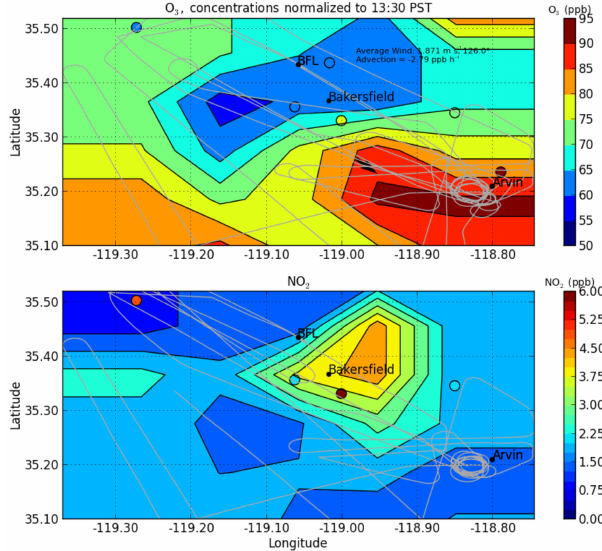
Figure 9. Horizontal patterns of O 3 (top) and NO 2 (bottom) during an ozone exceedance episode near Bakersfield on 14 August 2013. The grey lines represent the flight tracks, and the colored circles represent the surface network observations. Because of the contin- ual trend in ozone throughout the flight, the values in the top figure are all corrected to a reference time of 13:30PST. The black ar- row in the top figure represents the vector average wind observed in the ABL during that sortie showing a strong negative advection of ozone and a large positive advection of NO 2 into the Arvin region to the south. BFL is the Meadows Field Airport on the north end of urban Bakersfield. The colored circles represent the 13:00–14:00 surface site measurements from the ARB surface